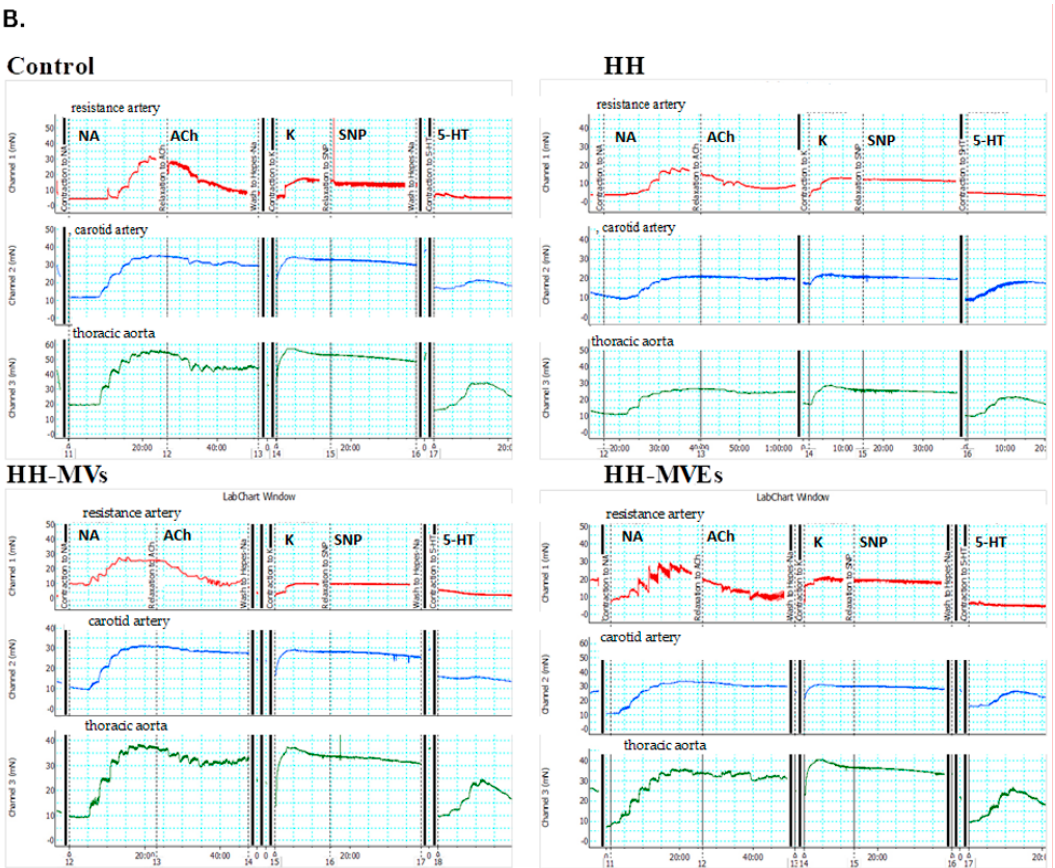
Figure 6. Functional investigation of the vascular wall of the thoracic aortas, carotid arteries and resistance arteries isolated from C, HH, HH-MVs, and HH-MVEs hamsters by the myograph technique ( n = 8 individual animals per group): ( A ) . The average maximal responses of contraction (to NA, 5-HT, K + ) and relaxation (to ACh, SNP) of resistance arteries (a) carotid arteries (b), and thoracic aortas (c) explanted from C, HH, HH-MVs, HH-MVEs hamsters; ( B ) . Representative recordings at selected time points for contraction (to NA, 5-HT, K + ) and relaxation (to ACh, SNP) of resistance arteries, carotid arteries, and thoracic aortas from hamsters in the C, HH, HH-MVs, and HH-MVEs groups. The statistically significant differences between the groups were calculated and are represented as * p ≤ 0.05 for values vs. the C group and as # p ≤ 0.05 for values vs. the HH group (one way ANOVA analysis).